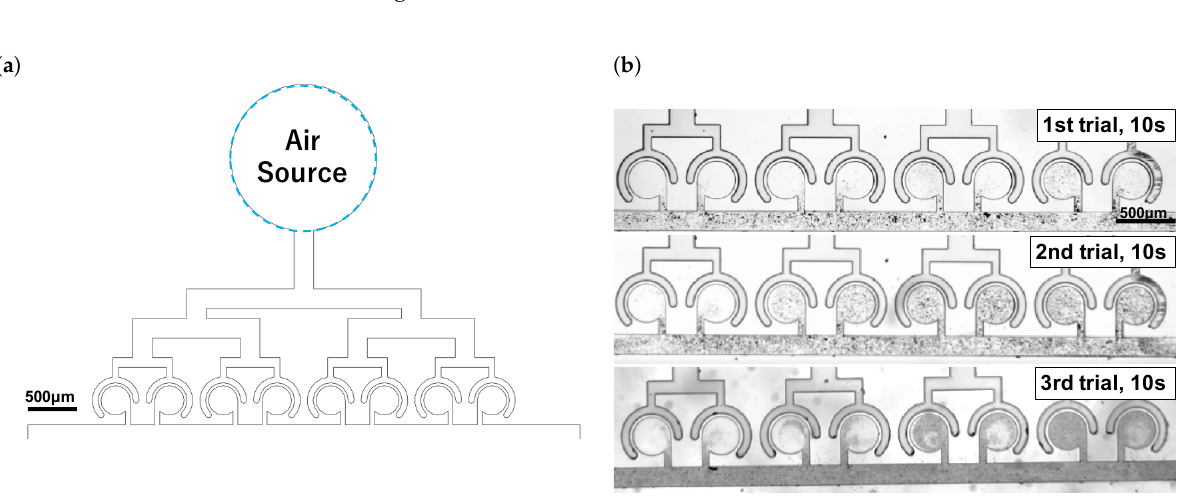
Figure A2. Verification of pressure uniformity. ( a ) To generate a concentration gradient using the enclosing angle, pressure must be uniform to generate a concentration gradient using the enclosing angle. ( b ) Experimental results. Concentrations were not